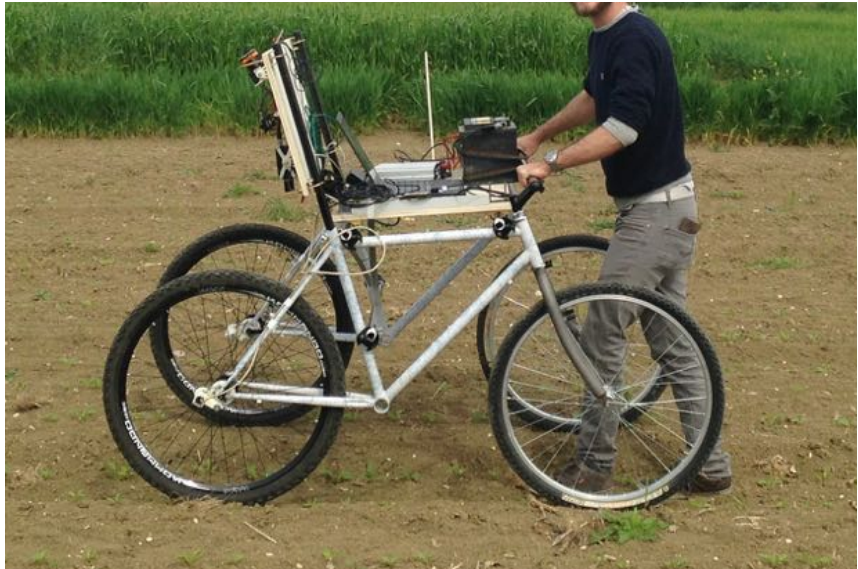
Figure 4. Acquisition process of the Sunflower dataset using a custom-built manual pushcart. Courtesy of Dr. Alberto Pretto—University of